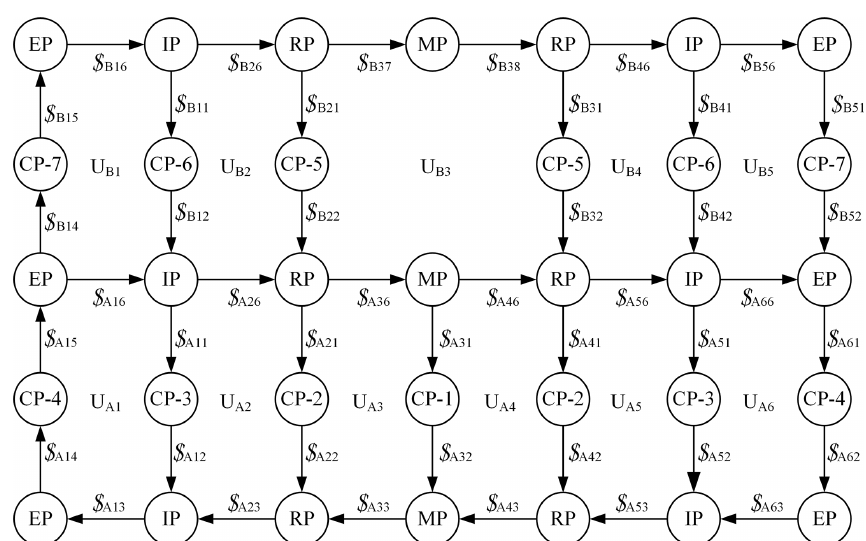
Figure A3. Topological constraint graph of the structure consisting of one deployable string, two rows of CPs, and the panels connected to the CPs in the next deployable